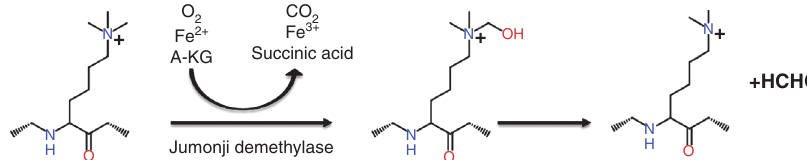
Figure 2 Jumonji demethylase